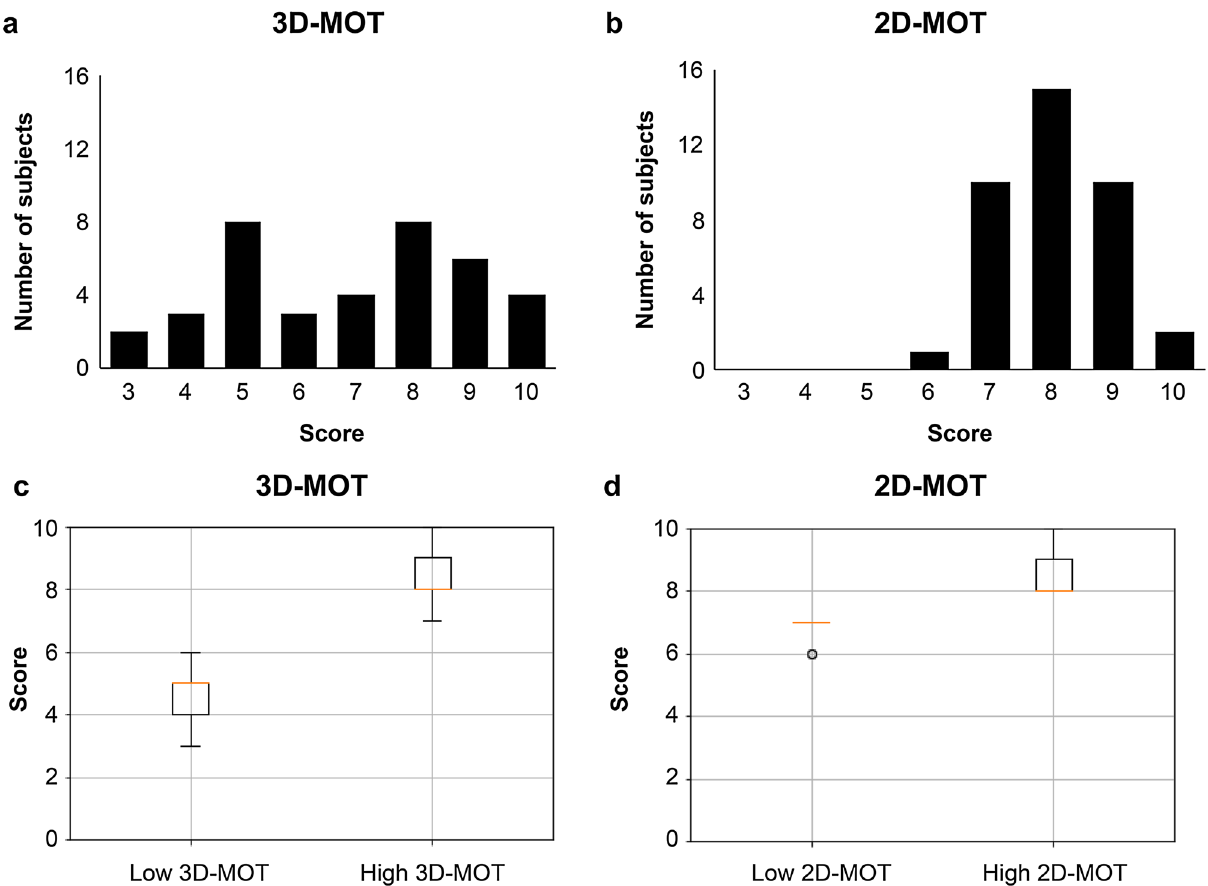
Figure 2. Behavioral results of 2D and 3D MOT. ( a ) The score on the 3D MOT (the number of correct answers out of 10 trials) showed a bimodal distribution. ( b ) The 2D MOT score (the number of correct answers out of 10 trials) showed a normal distribution. ( c ) The boxplot shows the significant difference in the 3D MOT score for the two groups, which were clustered according to the number of correct answers. ( d ) No significant differences were observed in the 2D MOT score for the two groups, which were clustered according to the number of correct answers. SVM k-NN Random forest 81 74 76 Table 5. The accuracy rate of prediction for the 3D multiple object tracking from the VR suitability predictor by the sports training in each algorithm.